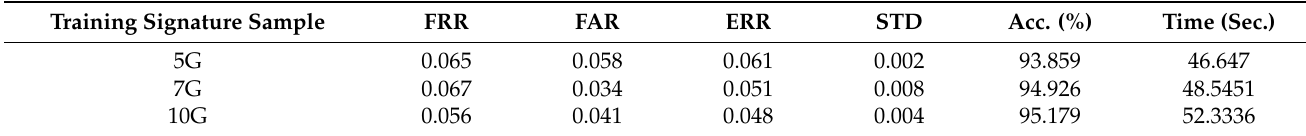
Table 8. Results of the proposed model on the CEDAR database.